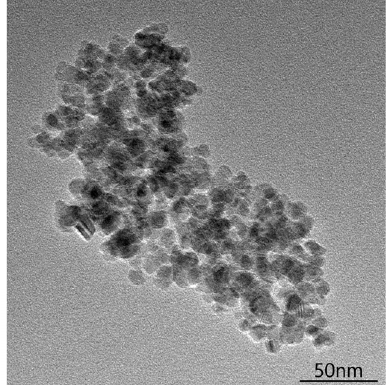
Figure 7. TEM images of the Fe 3 O 4 particles.